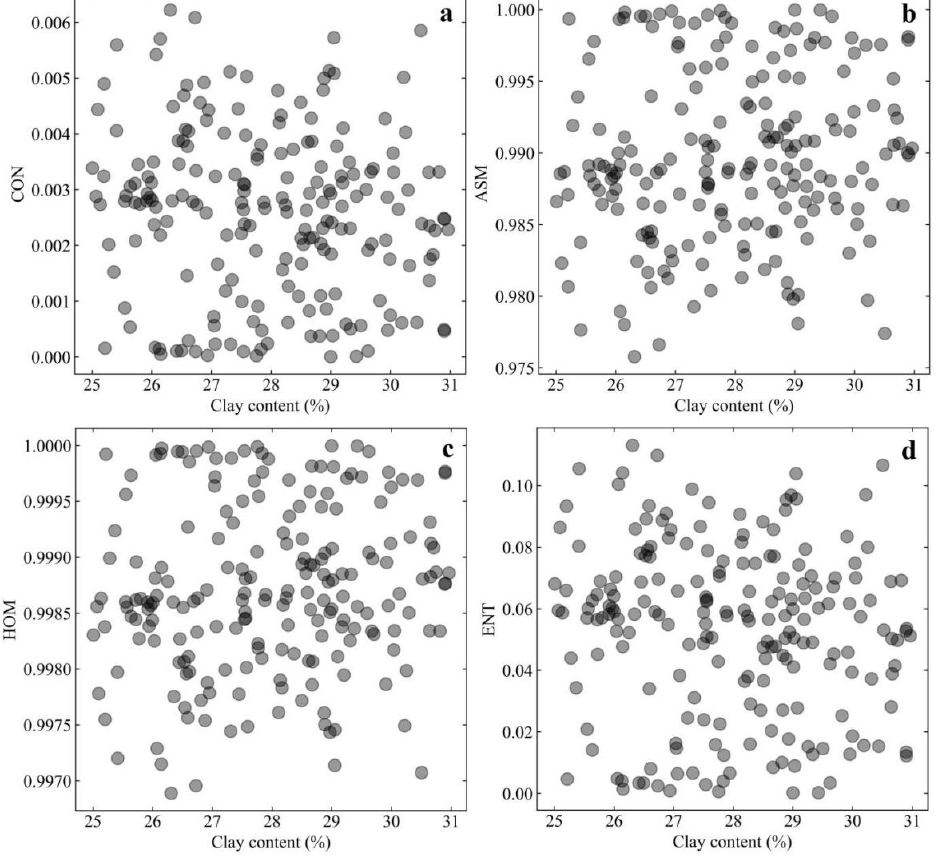
Figure 5. Scatter diagram between clay content and GLCM texture features. ( a ) for texture feature of CON; ( b ) for texture feature of ASM; ( c ) for texture feature of HOM; ( d ) for texture feature of